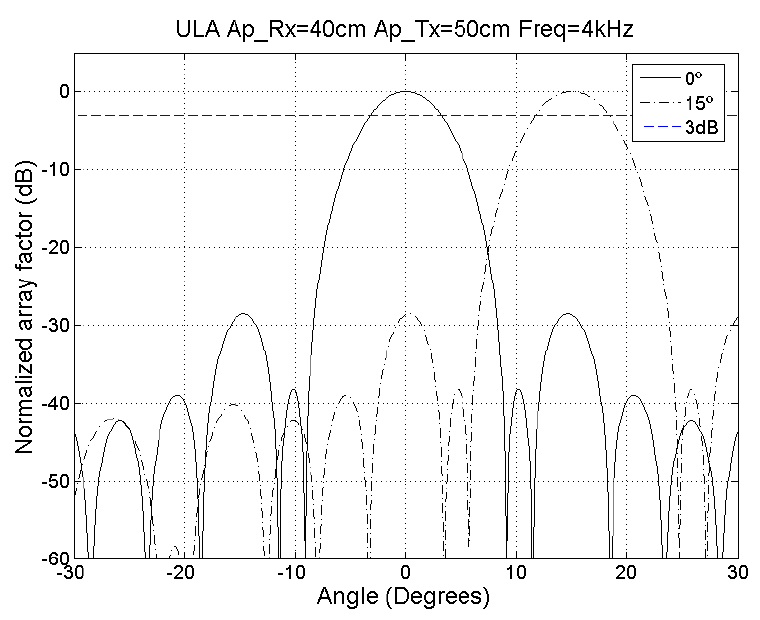
Figure 15. Beampattern for 0 ° and 15 ° for f = 4